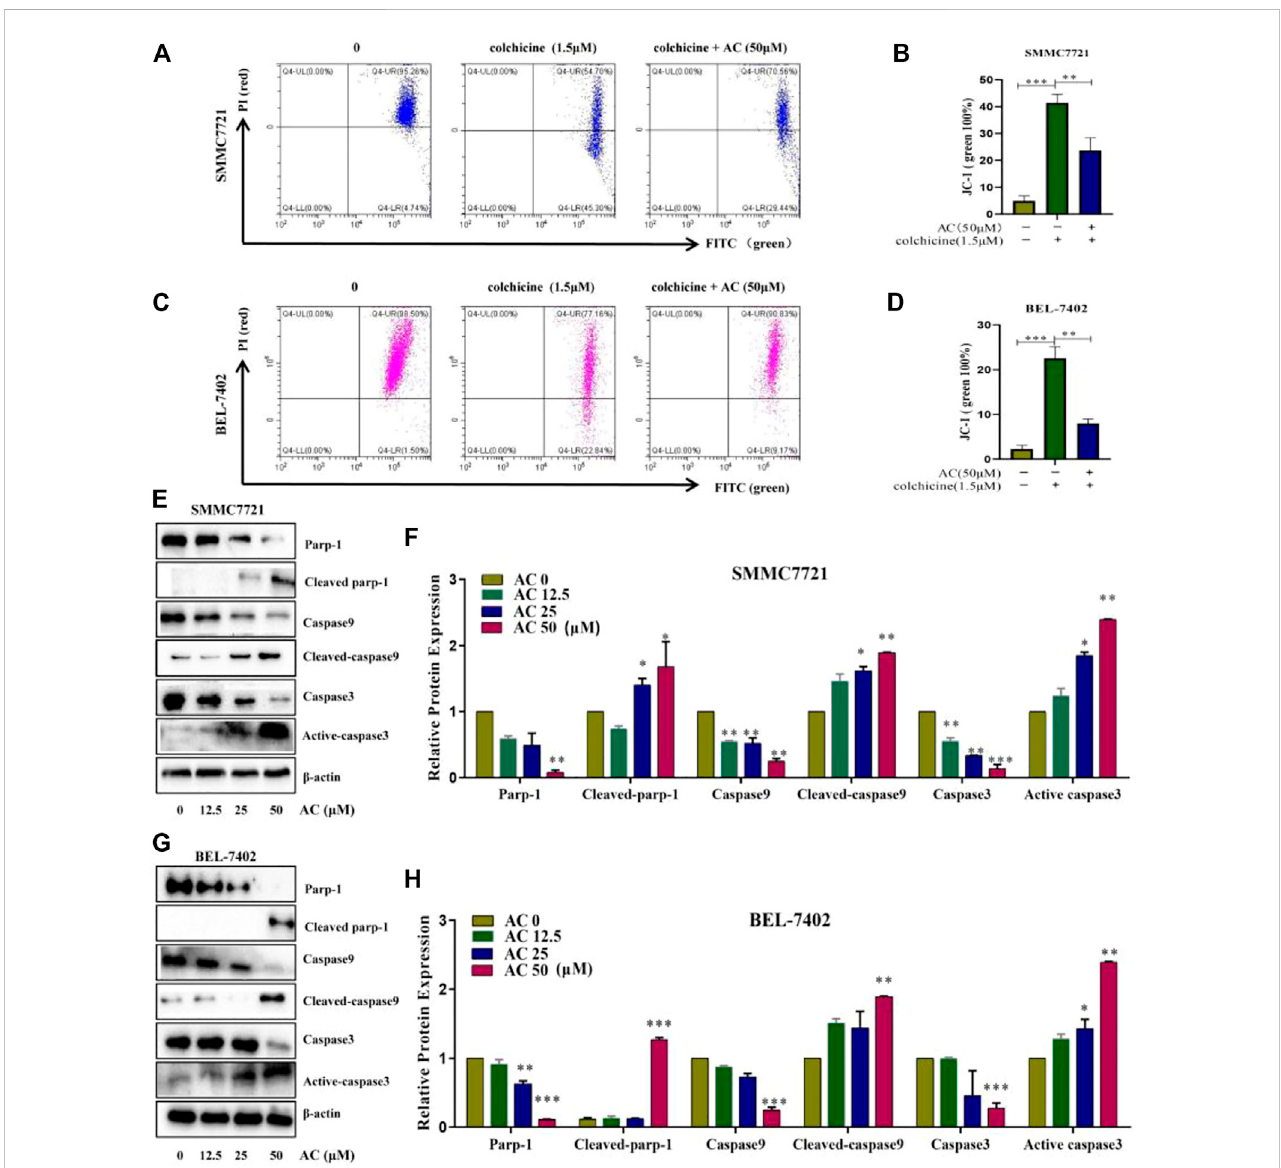
EffectsofAContheapoptosis-relatedsignalingpathwayproteins. (A , B) EffectofAConmitochondrialmembranepotentialinSMMC7721. (C , D) Effectof AConmitochondrial membranepotential inBEL-7402. (E , F) Westernblotdetection ofParp-1,Cleaved-parp-1,Caspase9, Cleaved-caspase9, Caspase3, and Active-caspase3 expression and statistical results in SMMC7721. (G , H) Western blot detection of Parp-1, Cleaved-parp-1, Caspase9, Cleaved-caspase9, Caspase3, and Active-caspase3 expression and statistical results in BEL-7402. * p < 0.05; ** p < 0.01; *** p < 0.001 (vs . 0